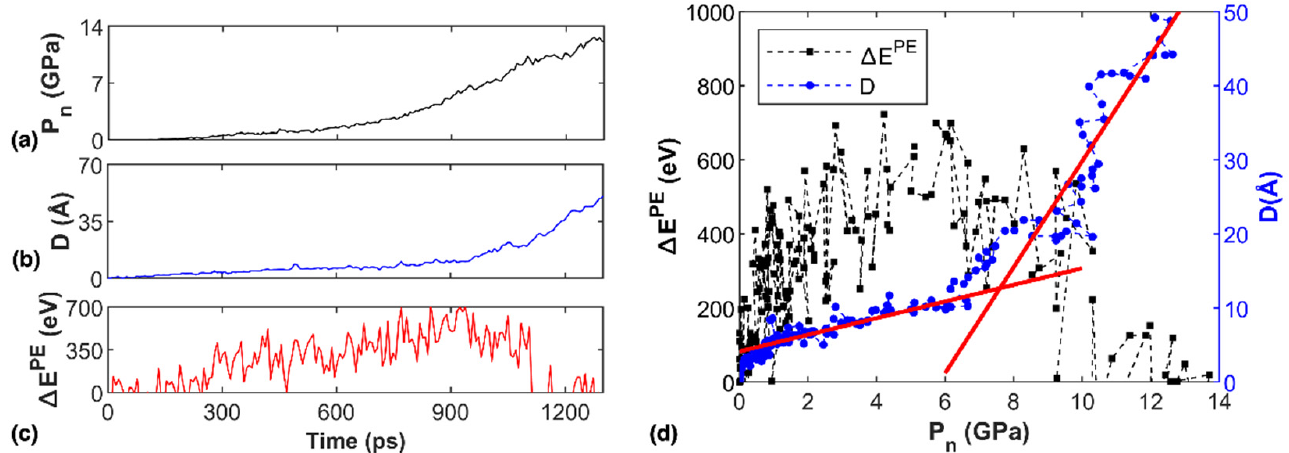
Figure 4. NaCl solution transportation in the diamond nanochannel. ( a ) The pressure trajectory; ( b ) The displacement of the water molecules trajectory; ( c ) The potential energy change trajectory; and ( d ) The potential energy change and displacement as a function of pressure. Two solid linear fitting lines identified the transition nominal pressure.